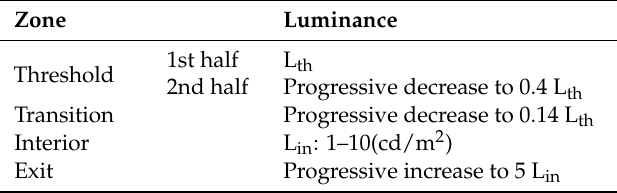
Table 2. Luminance requirements in the different zones of the road